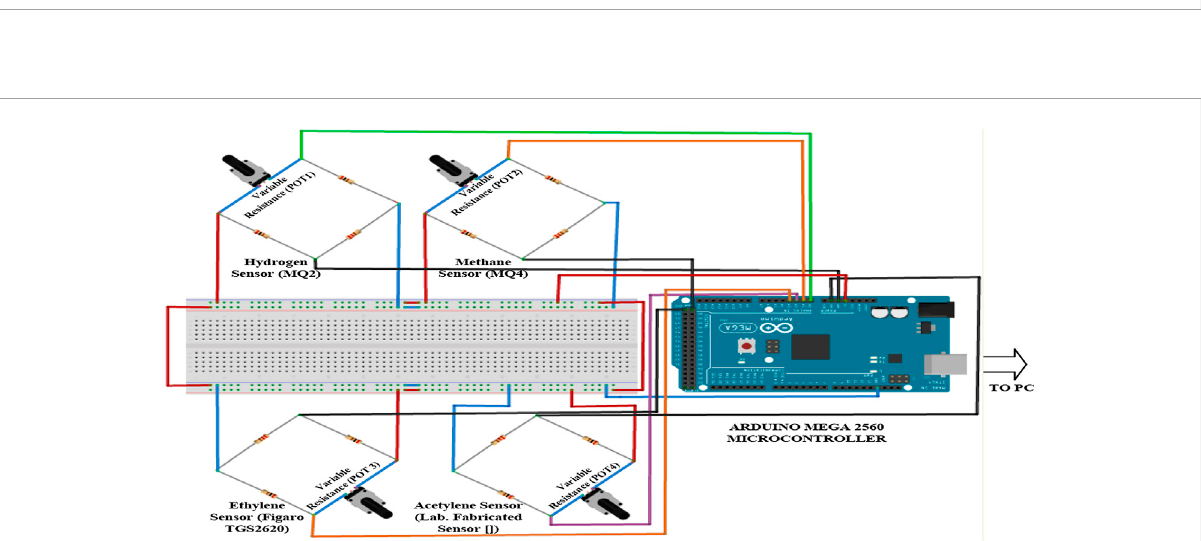
FIGURE 4 Schematic arrangement of a simulated E-Nose for online transformer incipient fault identi fi cation.